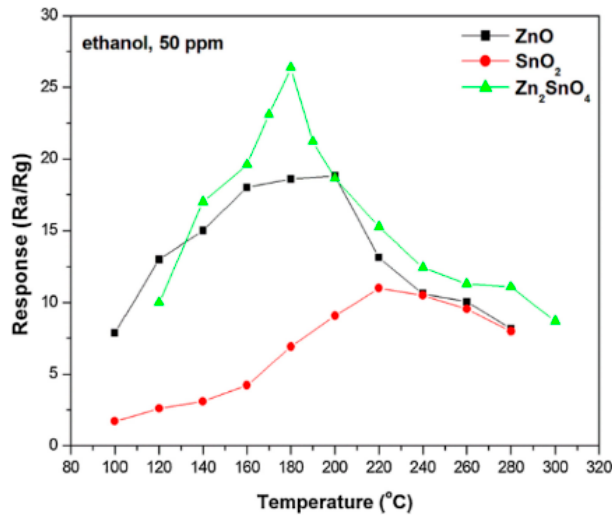
Figure 4. Response of the calcined ZnO, SnO 2 , and Zn 2 SnO 4 -based sensors to 50 ppm ethanol gas at different working temperatures [19].